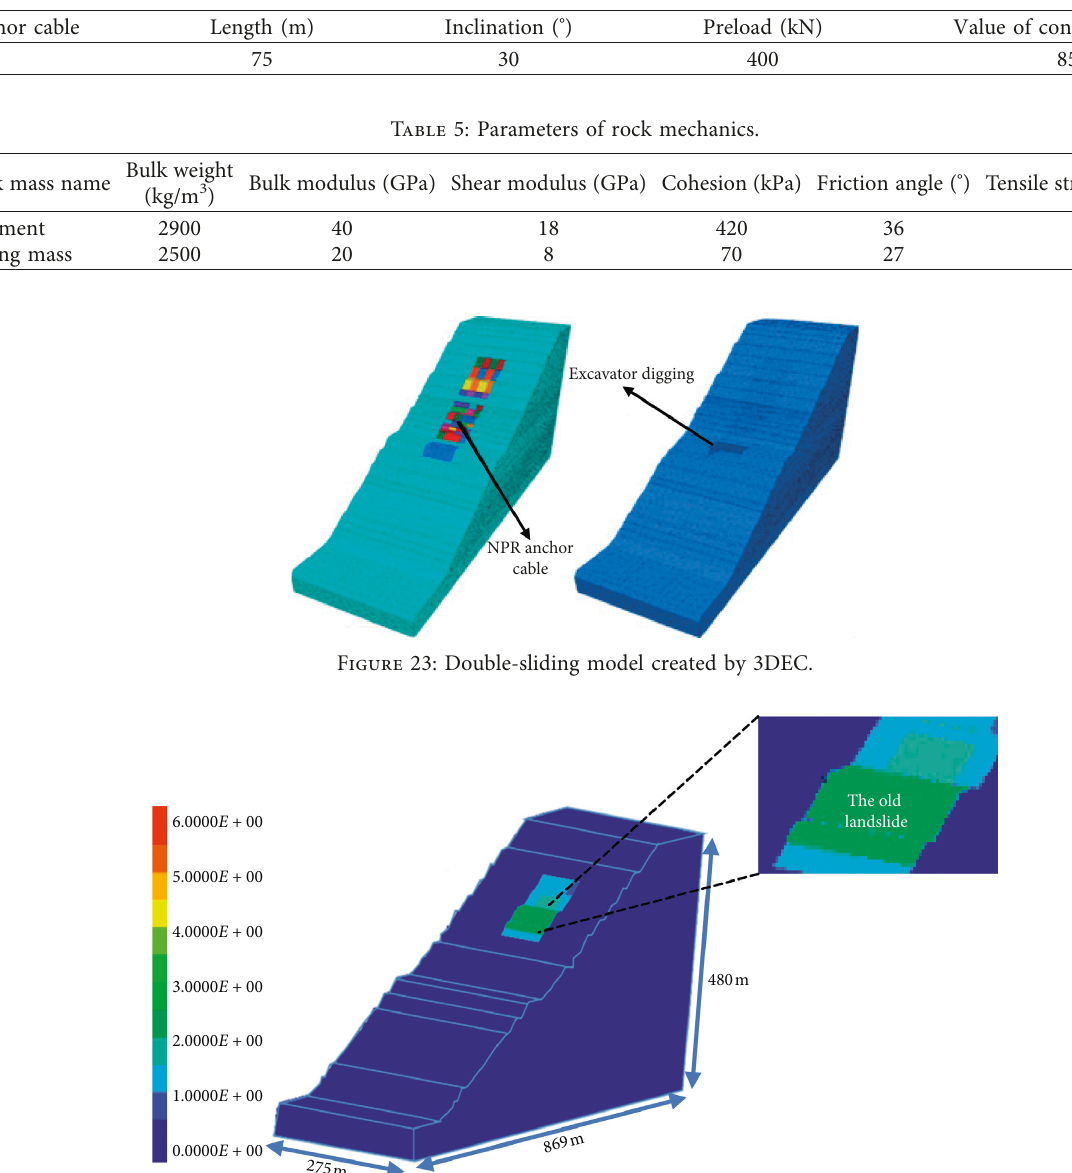
Table 4: Parameters of anchor cable.